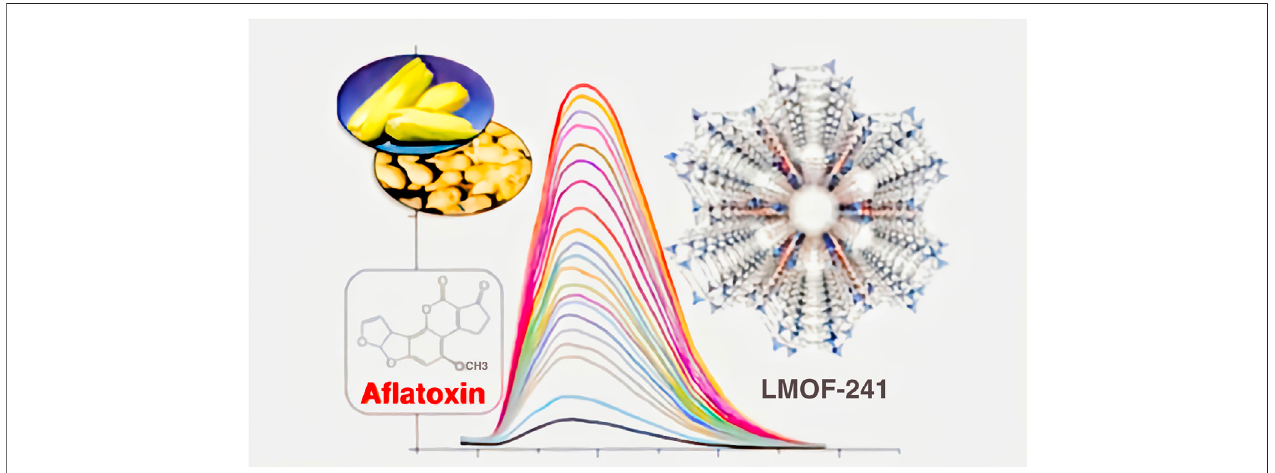
FIGURE 7 | Emission spectra of LMOF-241 with the incremental addition of a fl atoxin (Tan et al., 2018).